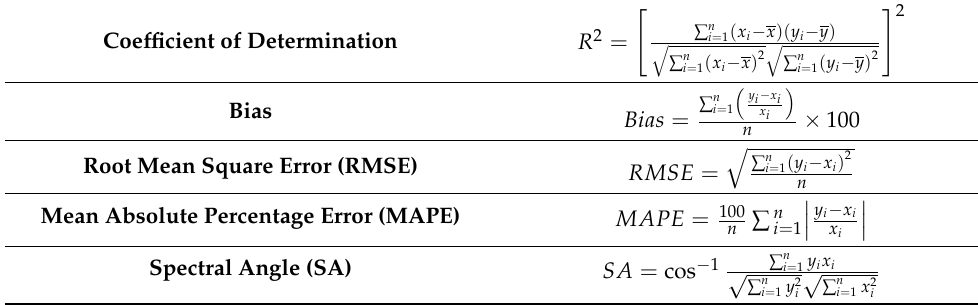
Table 2. Formulas for error metrics, where y i and x i represent atmospherically and glint-corrected R rs and in situ R rs ,